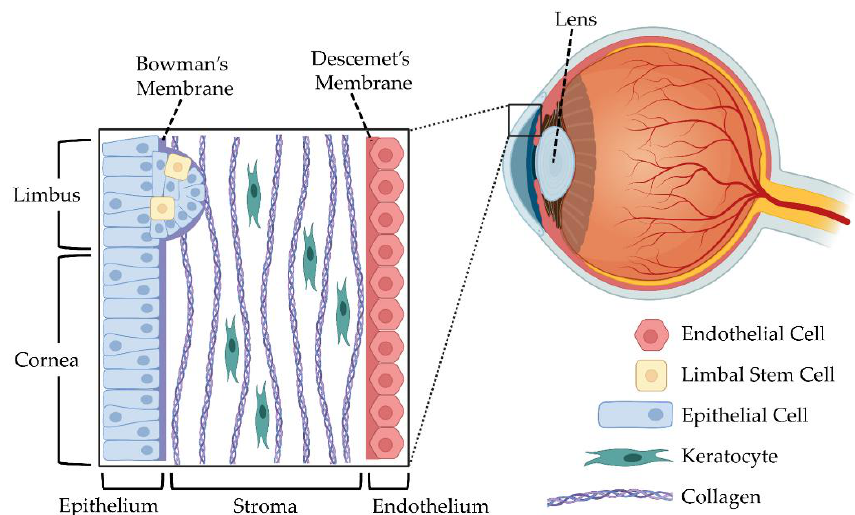
Figure 1. The human cornea constitutes the outermost layer of the eye. This transparent, avascular tissue consists of multiple layers including the epithelium, stroma, and endothelium. Other compo- nents include the limbus, the Bowman’s membrane, and the Descemet’s membrane. Figure created with Biorender.com.